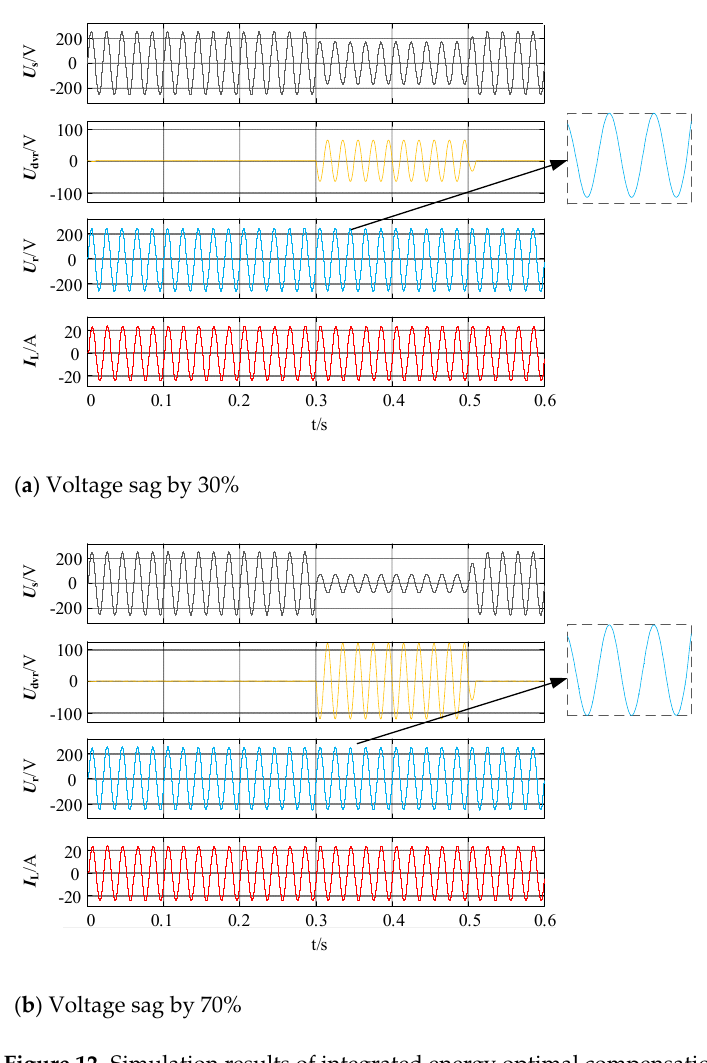
Figure 12. Simulation results of integrated energy optimal compensation.